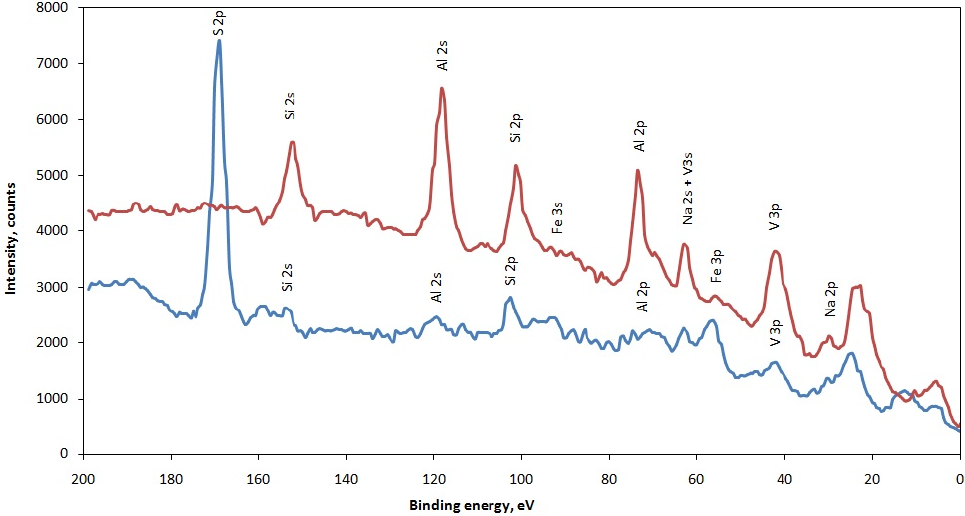
Figure 3. XPS spectra from the surface of ash (blue) and slag no. 3 (red) samples.